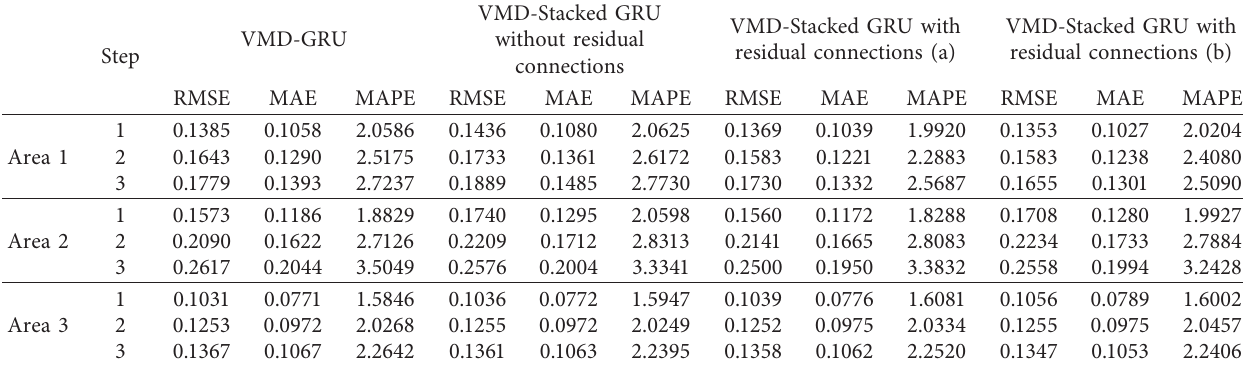
Table 4: Comparison of VMD-based models with and without residual